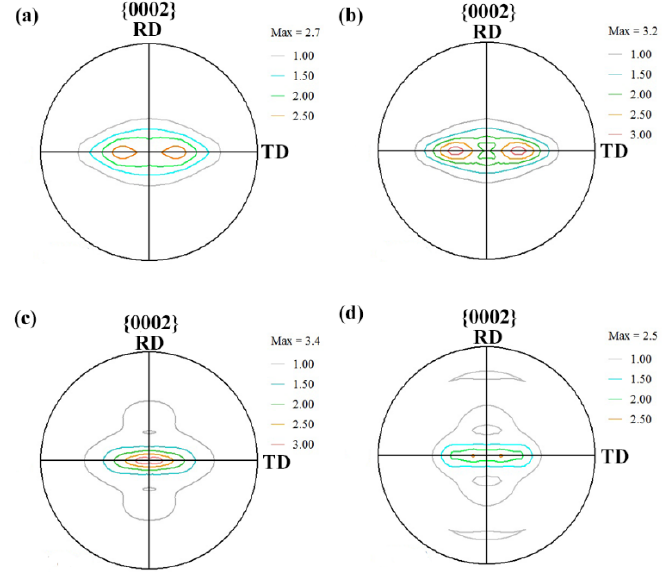
Figure 2. Pole figures of cold-rolled and warm-rolled samples through X-ray diffraction. ( a , b ) cold rolled with 80% and 90% reductions; ( c , d ) 600 °C rolled with 80% and 90% reductions; RD represents the rolling direction and TD represents the transverse direction.